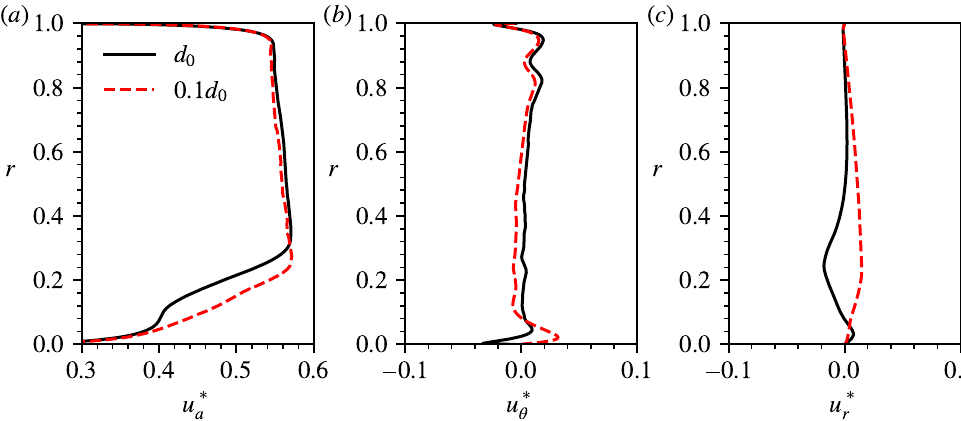
Figure 21. Spanwise distributions of the three velocity components on the stator outlet at different stage gaps: ( a ) axial; ( b ) circumferential; ( c )